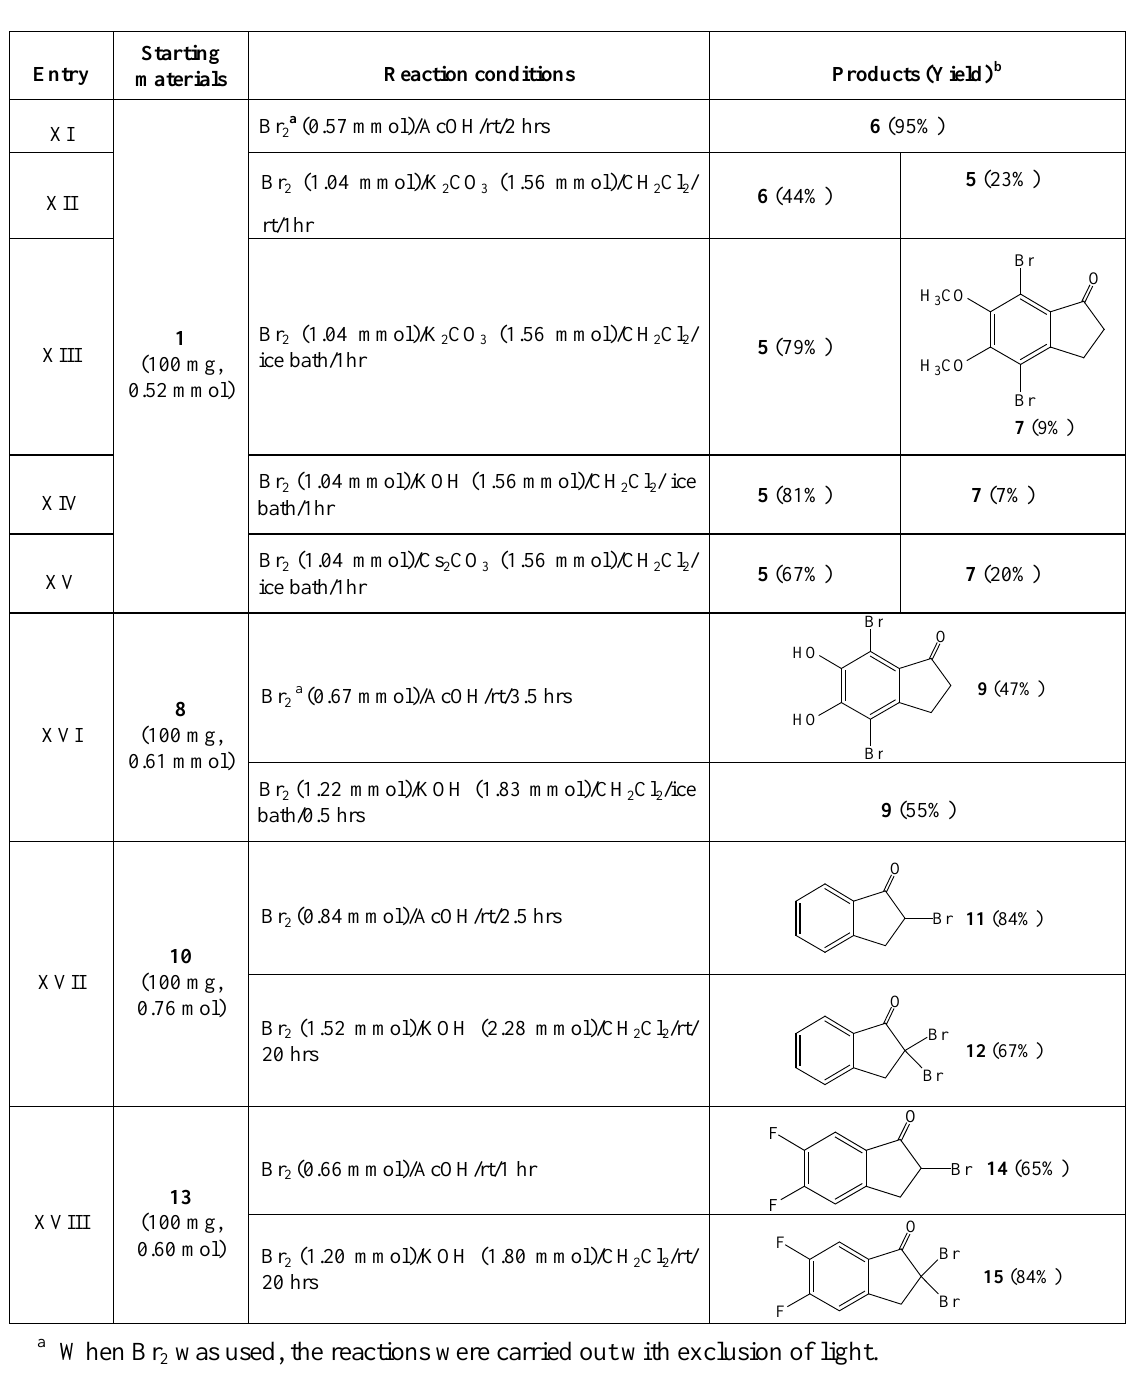
Table 2: Bromination of 5,6-dimethoxy-, 5,6-dihydroxy-,